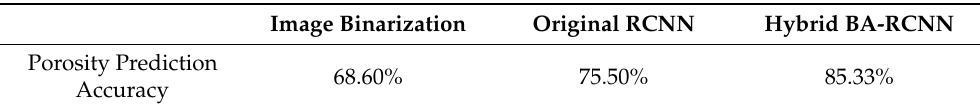
Table 12. Porosity average prediction accuracy (final